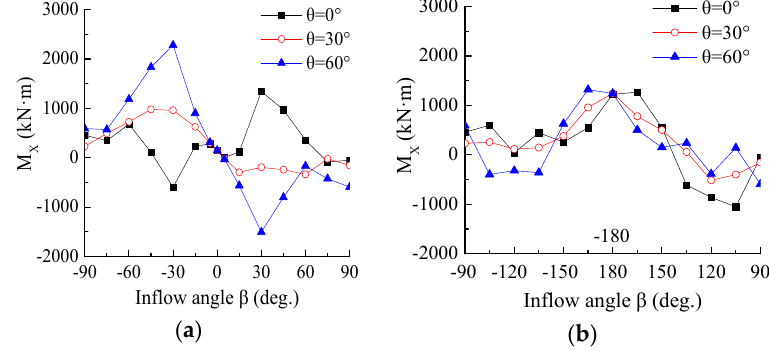
Figure 11. Curves of variation of the average wind torque M X with wind direction: ( a ) The average wind torque M X in the wind direction interval ( − 90 , 90 ); ( b ) The average wind torque M X in the wind direction intervals ( − 180 , − 90 ) and (90 , 180 ).